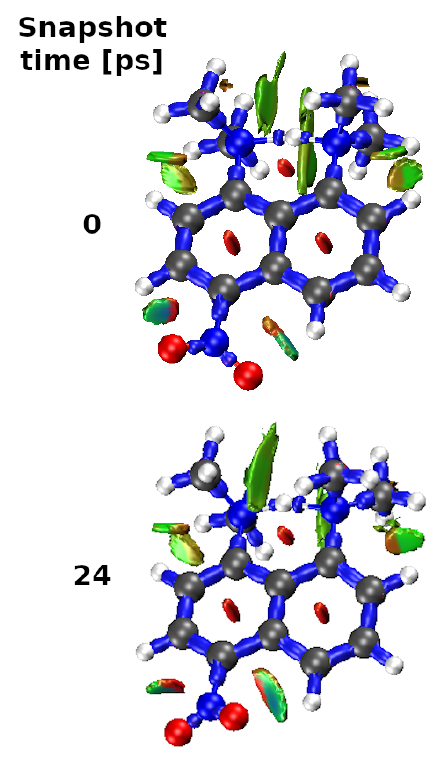
Figure 11. DORI isosurfaces (green spheres represent non-covalent interaction regions, blue s spheres represent covalent ones, and red spheres represent steric repulsions) in the RDG 0.5 a.u. isovalue for compound (4) at 100 K at 0 and 24